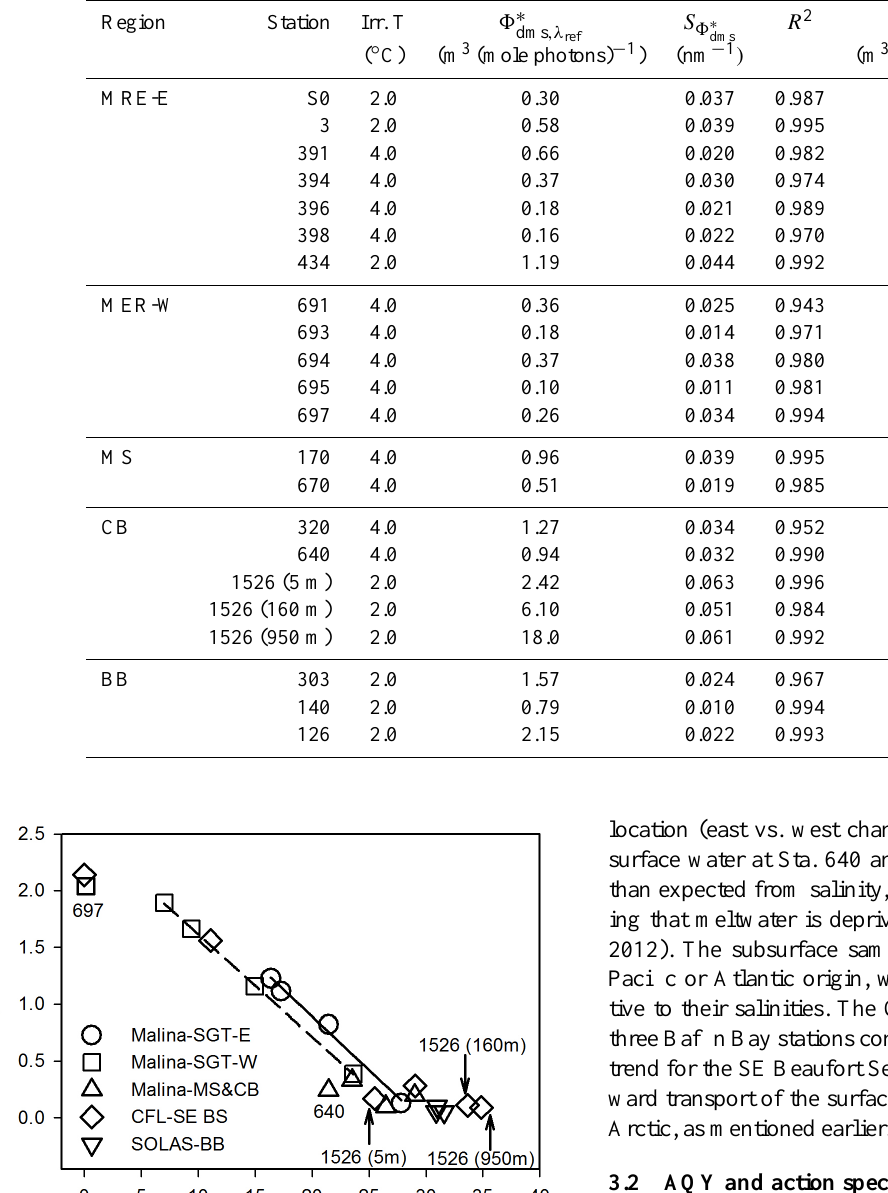
Table 2. Fitted 8 ∗ and S 8 ∗ values for Eq. (4) in the text. Also shown are irradiation temperature and 8 ∗ dms ,λ ref dms Eq. (4). R 2 is the coefficient of determination for regression of the predicted DMS photodegradation rate against the measured rate in an irradiation cell (see Sect. 2.4). Keys for the “Region” column are the same as in Table 1.